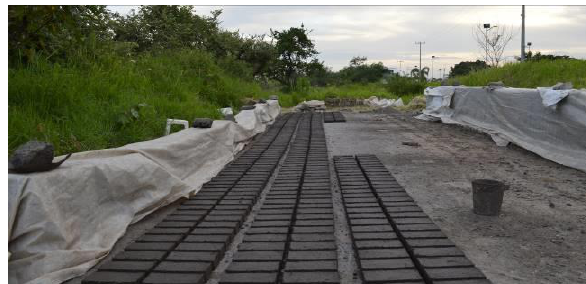
Figure 7. Manufacture area of the ceramic bricks of the region. Photo: Adrià Sánchez Calvillo (2018).